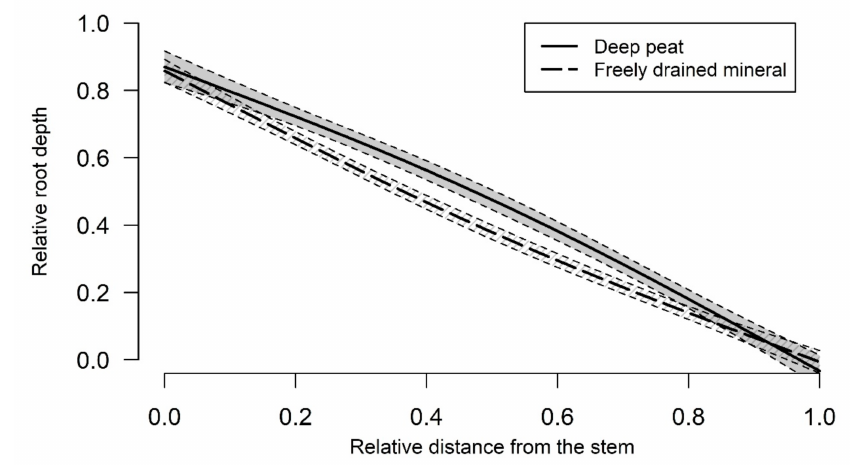
Figure 1. Relative structural root-plate depth distribution of measurement points at relative distance from the stem of wind-thrown trees. (Grey area denotes 95% confidence